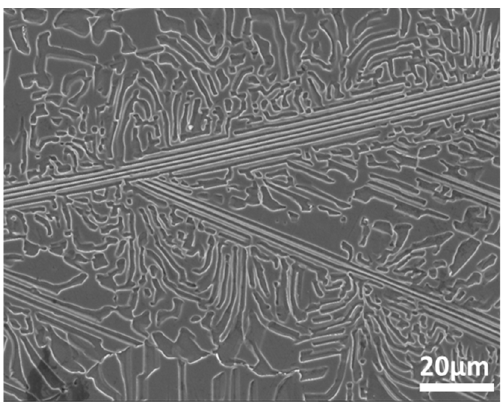
Figure 1. Microstructure of AlCoCrFeNi 2.1 .